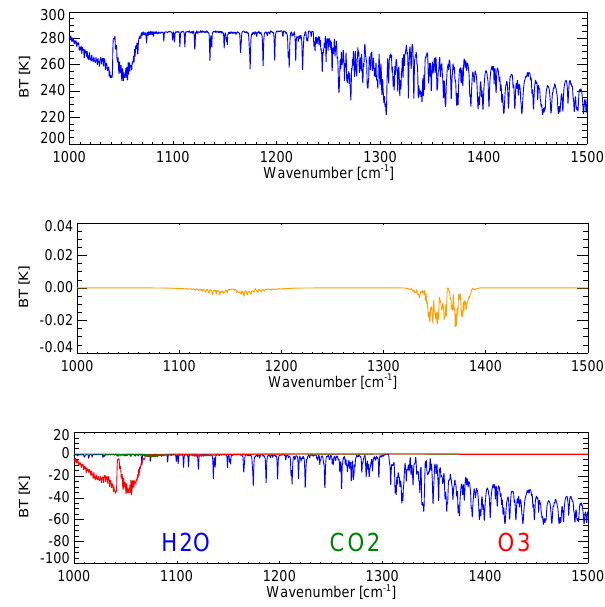
Fig. 1. Simulated spectra in the region of the SO 2 ν 1 and ν 3 bands. Top panel shows a simulated spectrum for a standard atmosphere. Middle panel shows contribution of climatological background lev- els of SO 2 . Bottom panel shows contribution of main interfering species (water vapour, CO 2 and